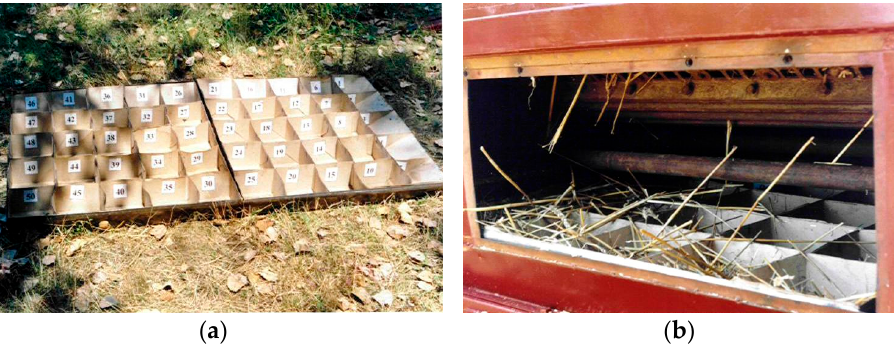
Figure 2. Block of collecting boxes. ( a ) Before being mounted under the threshing apparatus. ( b ) Mounted under the threshing apparatus.